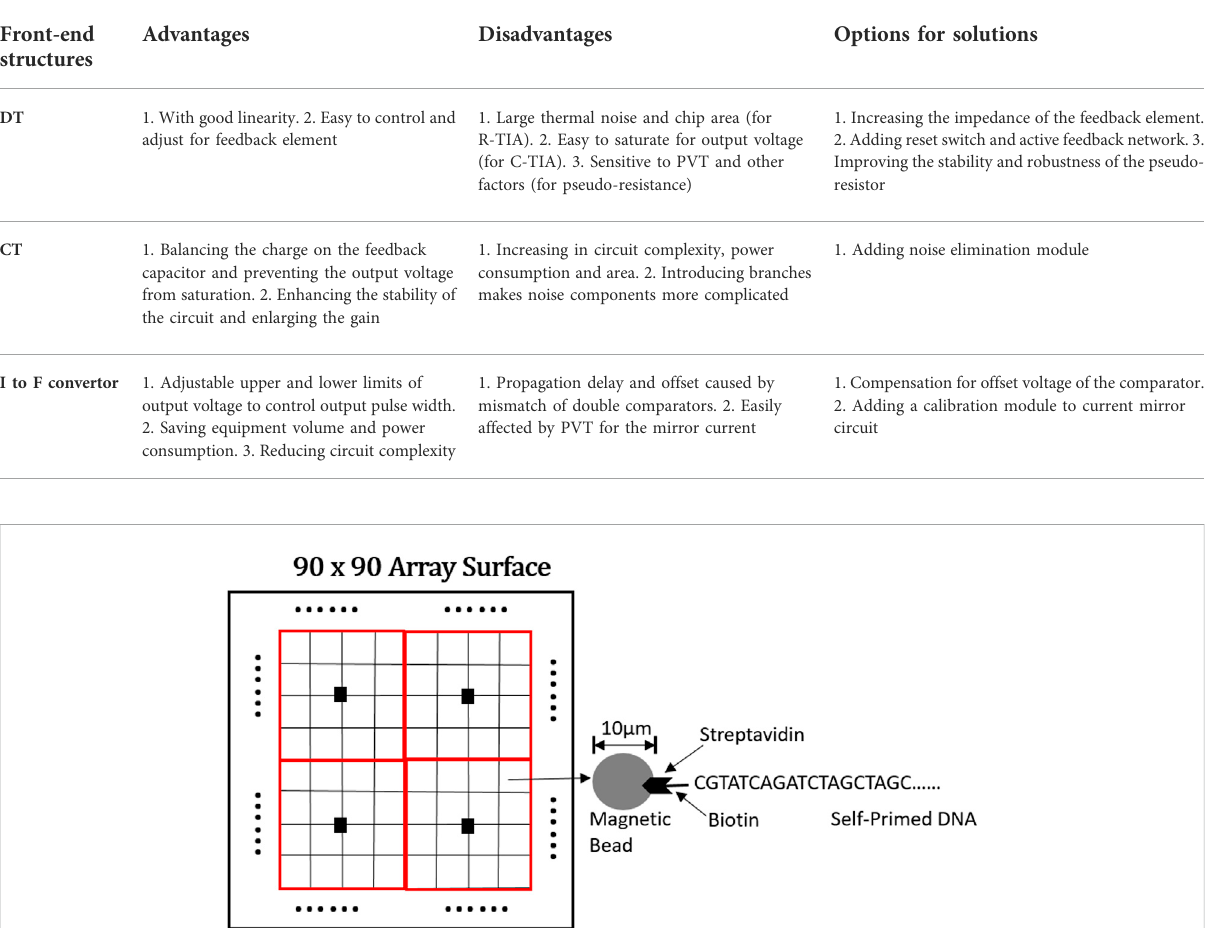
FIGURE 11 Part schematic diagram of a 90 × 90 sensor array interface (Manickam et al.,